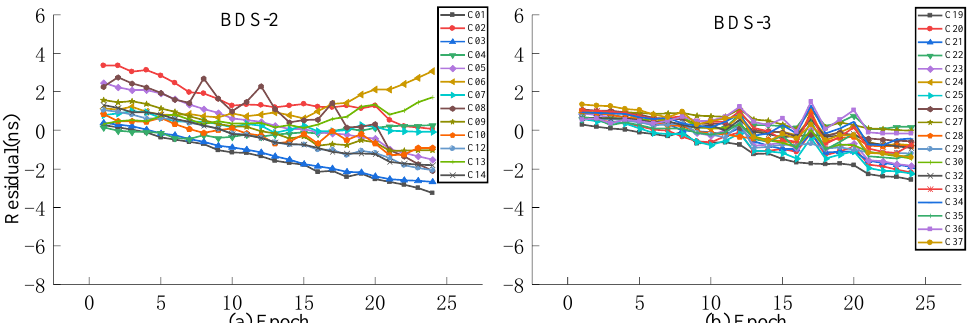
Figure 15. The residual plot of the GM model using the 6th hour update ultra-fast clock product of the day. ( a ) The residual value of BDS-2 predicted after 6 h. ( b ) The residual value of BDS-3 predicted after 6 h.